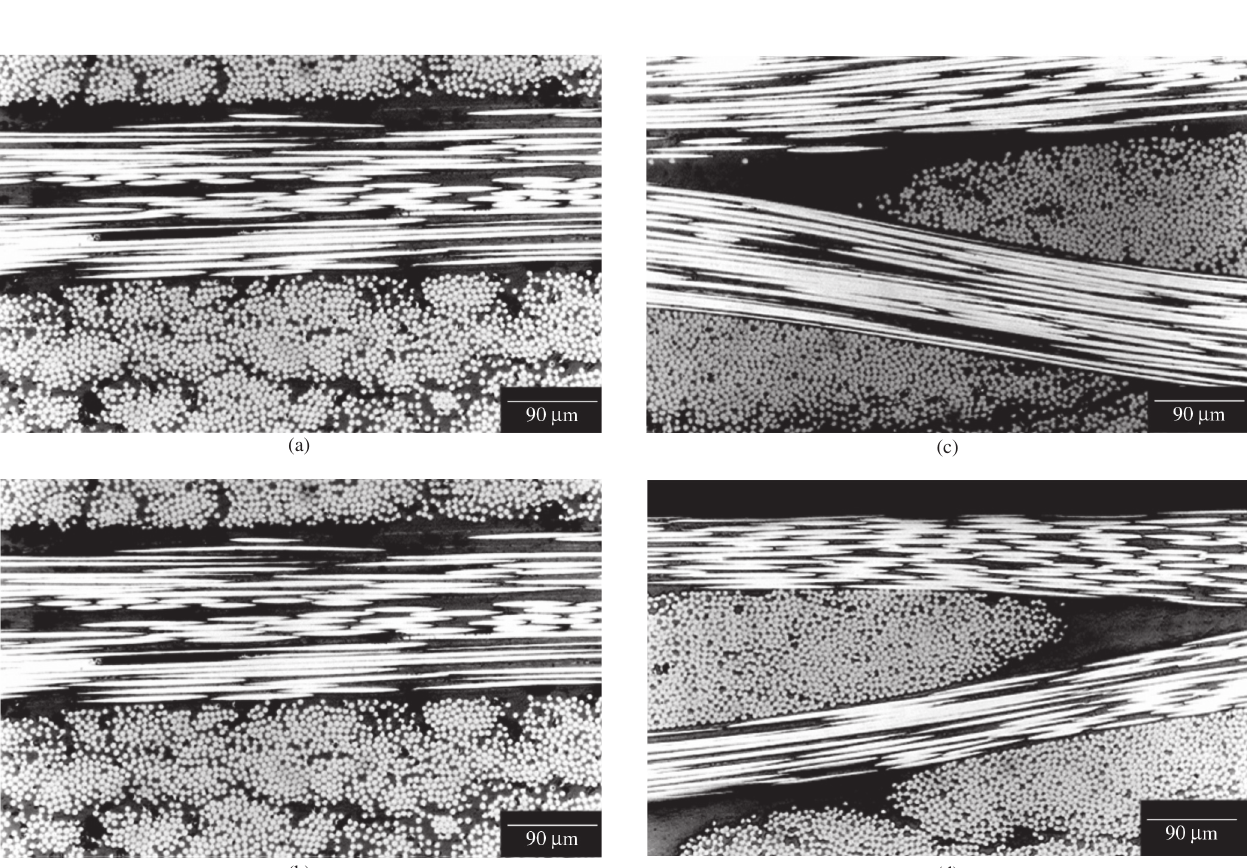
Figure 1 . Cross-sectional microstructures of the tested carbon-epoxy laminates: a) TP120; b) TP180; c) FB120; and d) FB180. Typical carbon fiber diameter is 7 m m.